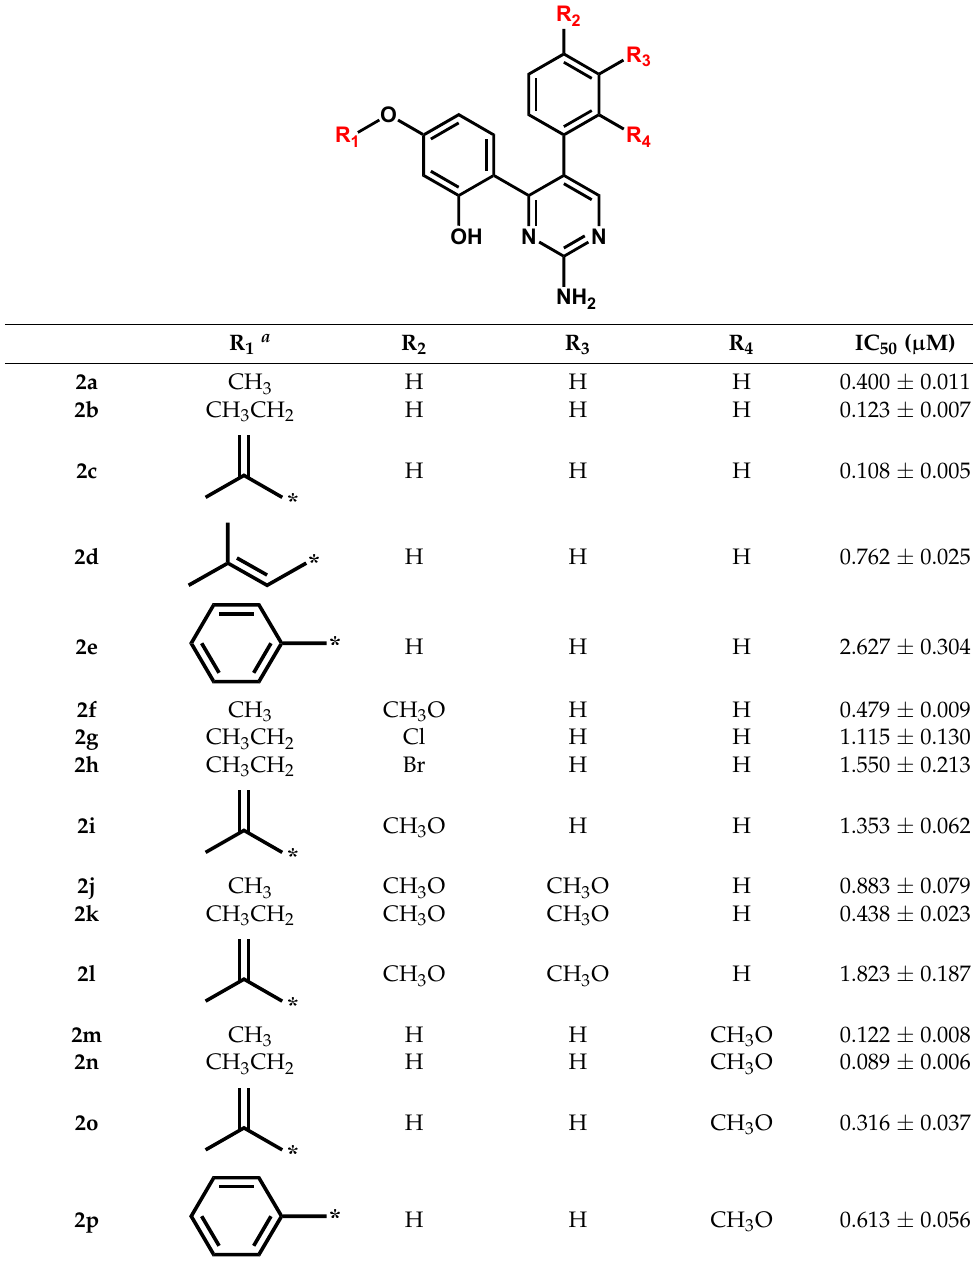
Table 2. Structures and inhibitory activities of the derivatives of Inhibitor 2 against the G2019S mutant.